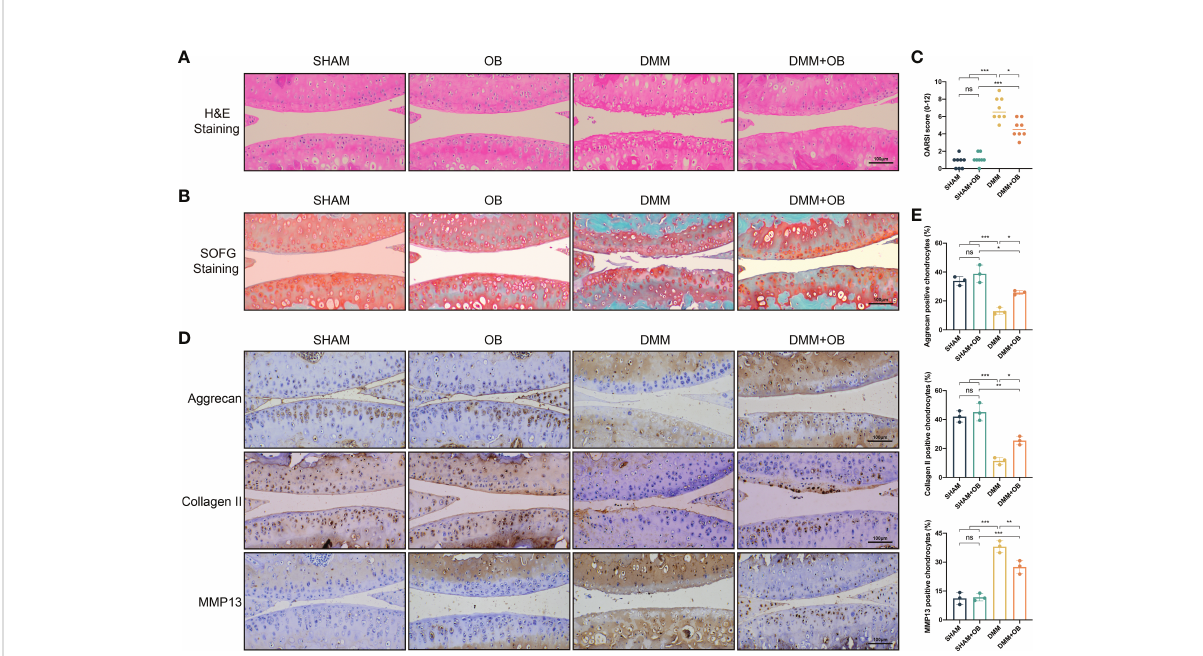
FIGURE 8 OB alleviated cartilage destruction in DMM – induced mice OA model. (A) H&E staining and (B) SOFG staining of the mice knee articular cartilage. (C) Quantitative analysis of the degree of cartilage destruction among groups by the OARSI scoring system (n=8). (D) Immunohistological staining and (E) quantitative analysis of anabolic and catabolic-related proteins (Aggrecan, Collagen II, and MMP13) (n=3). Data were presented as means ± SD (n = 3). ns, no signi fi cance; * p < 0.05; ** p < 0.01; *** p < 0.001.